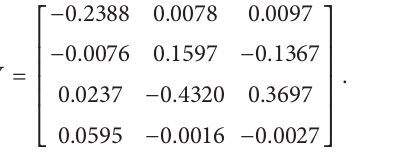
weighted factor is 𝑚 = 2 and the iterative stopping threshold value is 10 −5 . The 290 × 3 matrix composed by GA-LPP fusion features is computed by GG clustering and the clustering center matrix